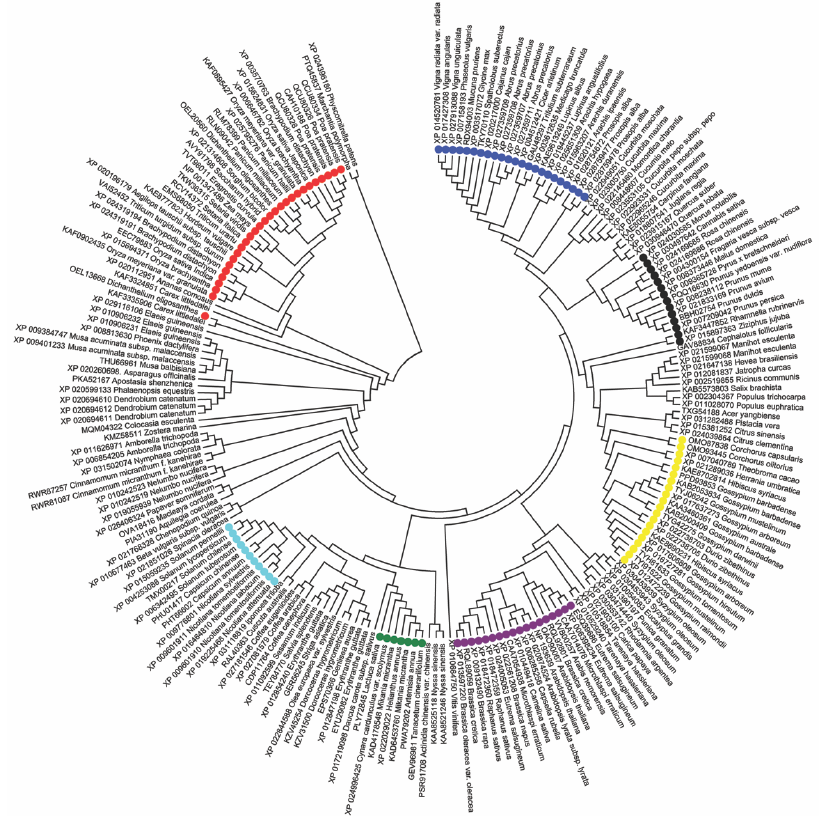
Figure 4. Maximum-likelihood phylogenetic unrooted tree based on APOSTART_6 similar amino acid sequences. The tree has the highest log likelihood (-45391.1656) and is condensed with bootstrap value >70. Phylogenetic analysis was performed using Neighbor-Join and BioNJ algorithms to a matrix of pairwise distances estimated using a JTT model and a discrete γ distribution (5 categories (+G, parameter = 0.6937)). The analysis involved 208 amino acid sequences and was conducted in MEGA7 [23]. Bootstrap values are reported in Figure S3 for more accuracy. Poaceae are indicated in red, Solanaceae in light blue, Asteraceae in green, Malvaceae in yellow, Brassicaceae in purple, Rosaceae in black, and Fagaceae in dark